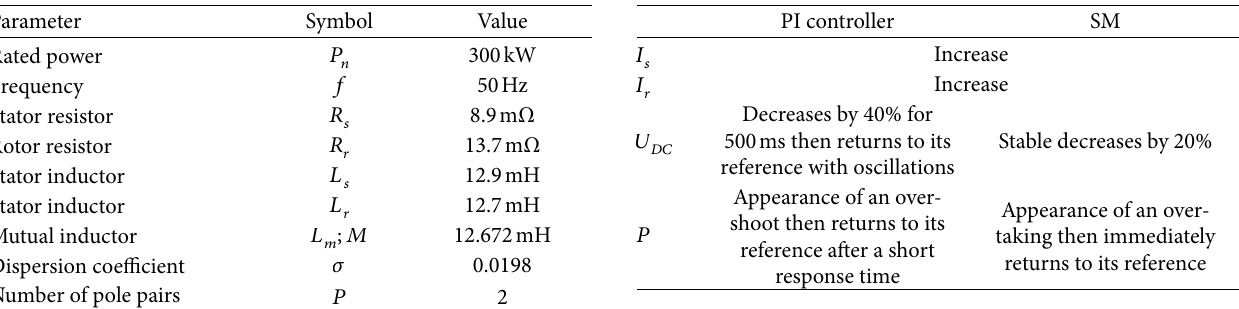
Table 3: Comparison results for 20% depth of stator voltage.